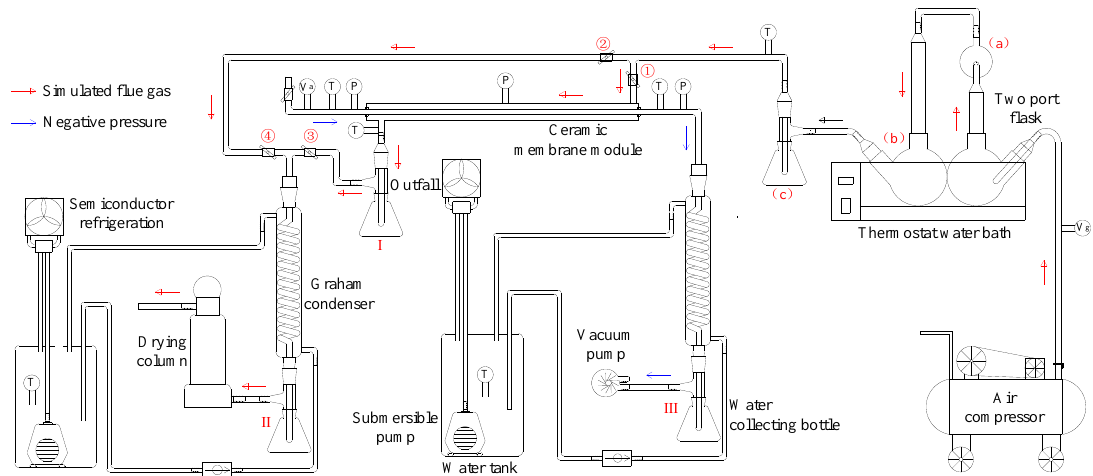
Figure 5. Ceramic membranes water and waste heat recovery from simulate flue gas experiment platform.